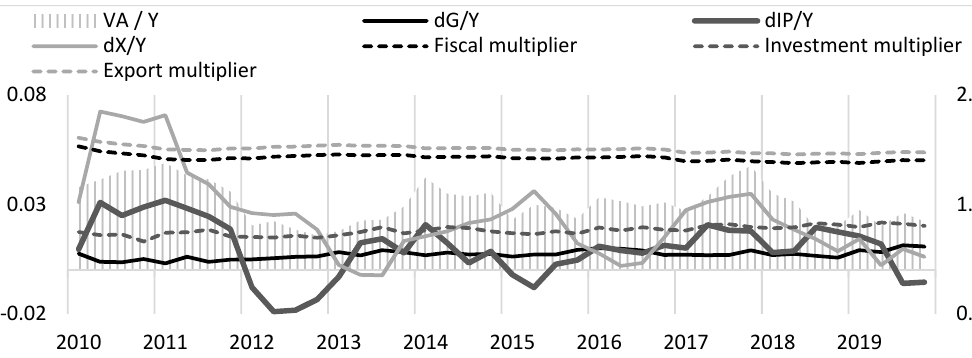
Figure 12. Growth rate of gross value added (main variables)—Poland, own work, source: Eurostat.